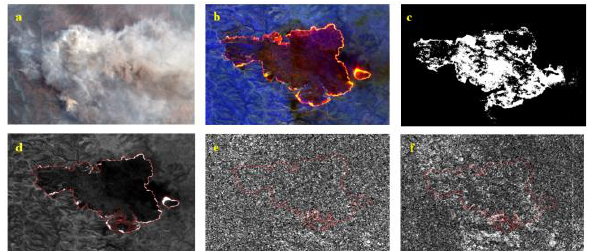
Figure 7. Detailed U-net architecture